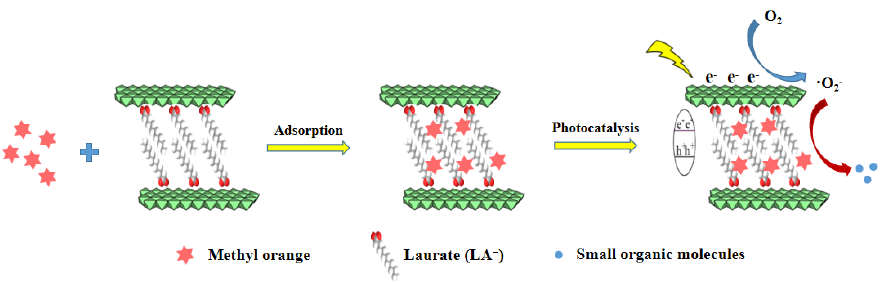
Figure 9. A possible mechanism of intercalated laurate enhanced photocatalytic activities of Ni/Cr